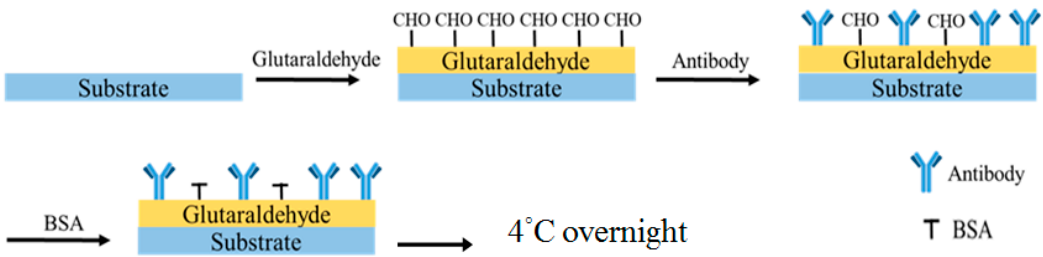
Figure 2. Procedure for the immobilization of the UL16 binding protein 2 (ULBP2) antibody onto a sensor window by drop-coating.